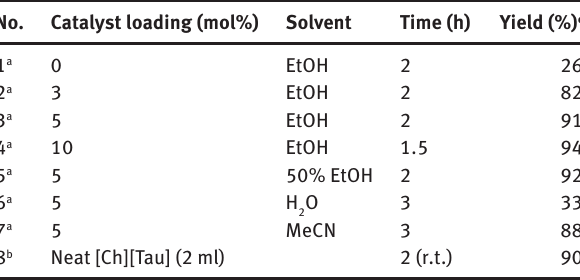
Table 2: Screening of reaction conditions in model reaction.